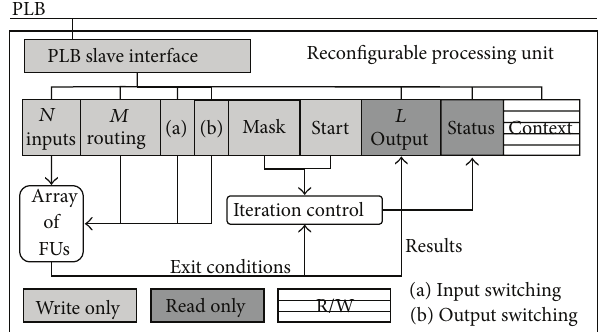
F 10: RPU architecture overview, with PLB